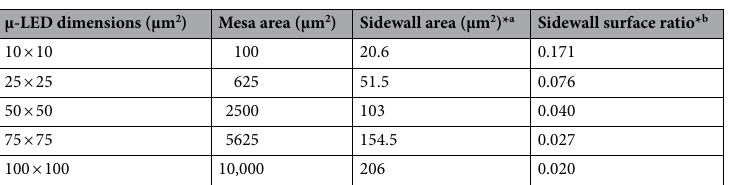
Table 1. Comparison of total surface area and side wall surface area of different sizes of μ-LEDs. * a Mesa depth = 515 nm. * b Sidewall surface ratio = sidewall area/total surface